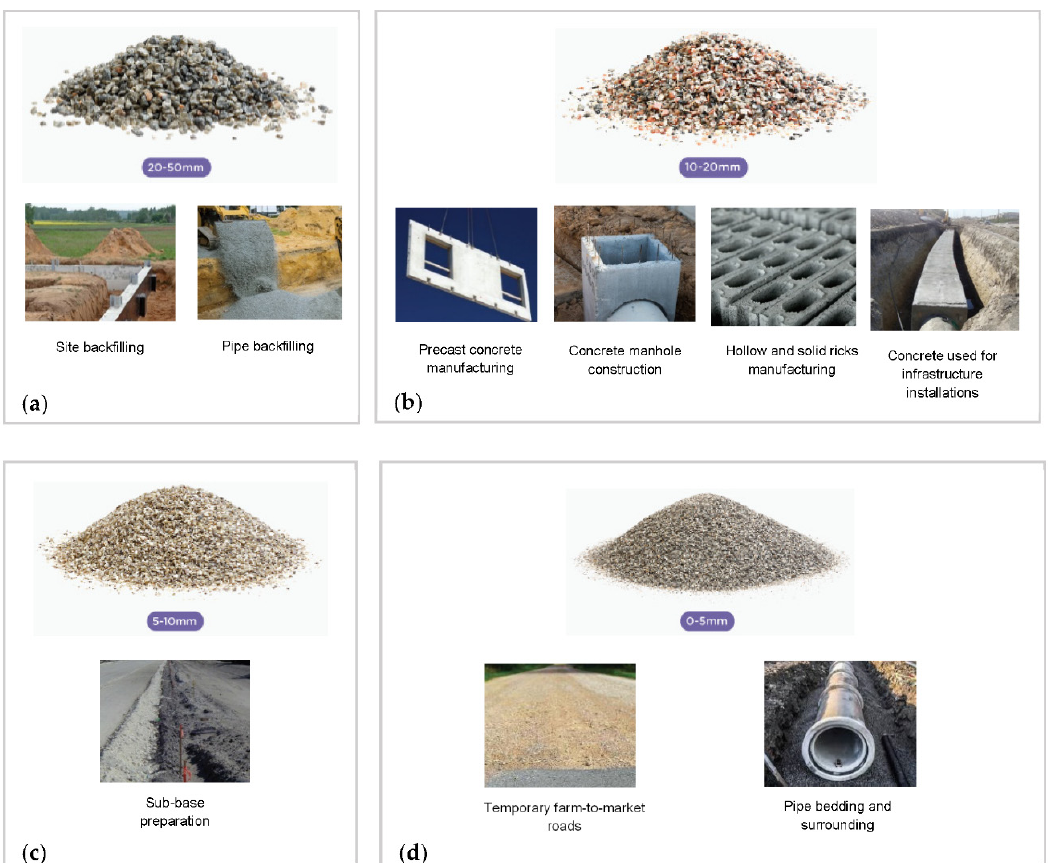
Figure 8. Pictorial vignettes of recycles aggregates and their potential uses, ( a ) 20–50 mm aggregates, ( b ) 10–20 mm aggregates, ( c ) 5–10 mm aggregates, and ( d ) 0–5 mm aggregates. (Source: SIRC [16])